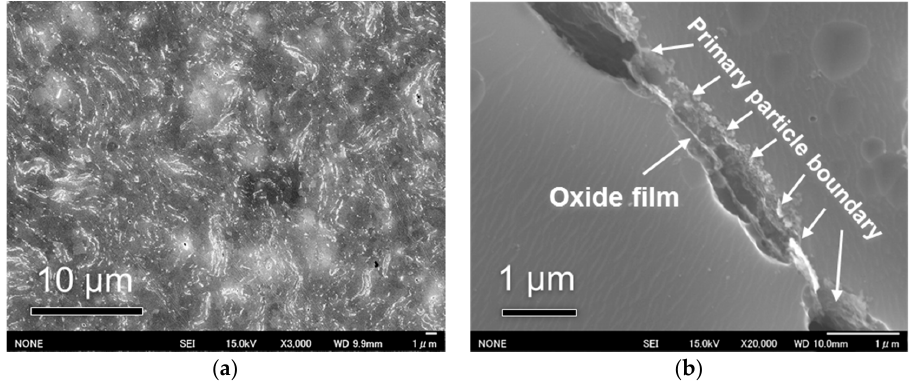
Figure 5. Microstructure of CNT–Al composite sintered at 900 K at different magnifications. ( a ) A low ‐ magnification view. ( b ) A local view.